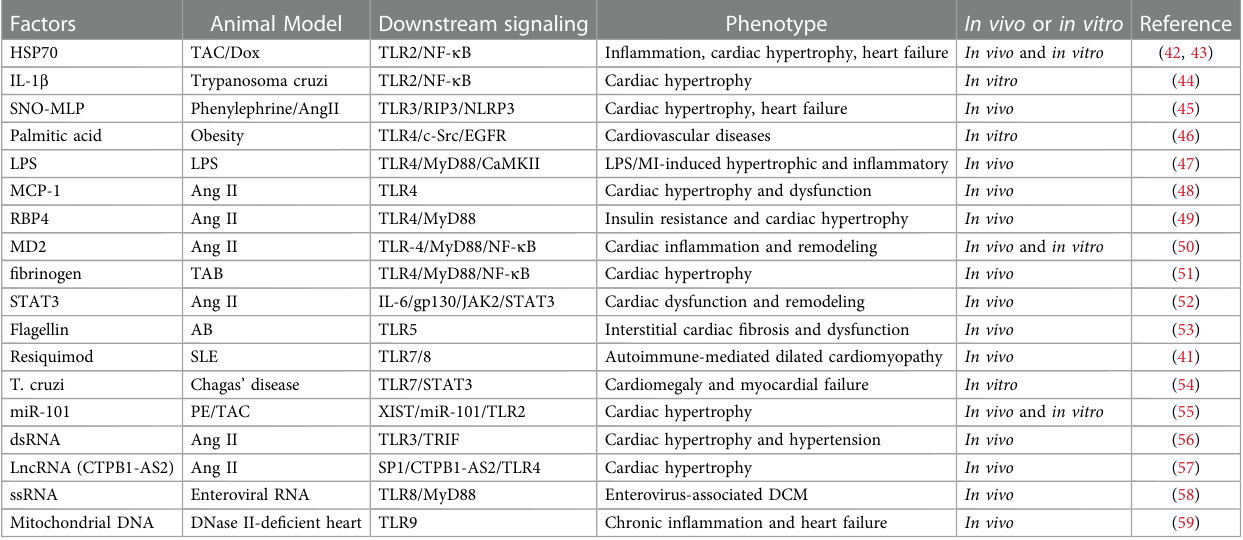
TABLE 1 Summary of various factors that can interact with speci fi c TLRs, leading to cardiac hypertrophy and cardiac